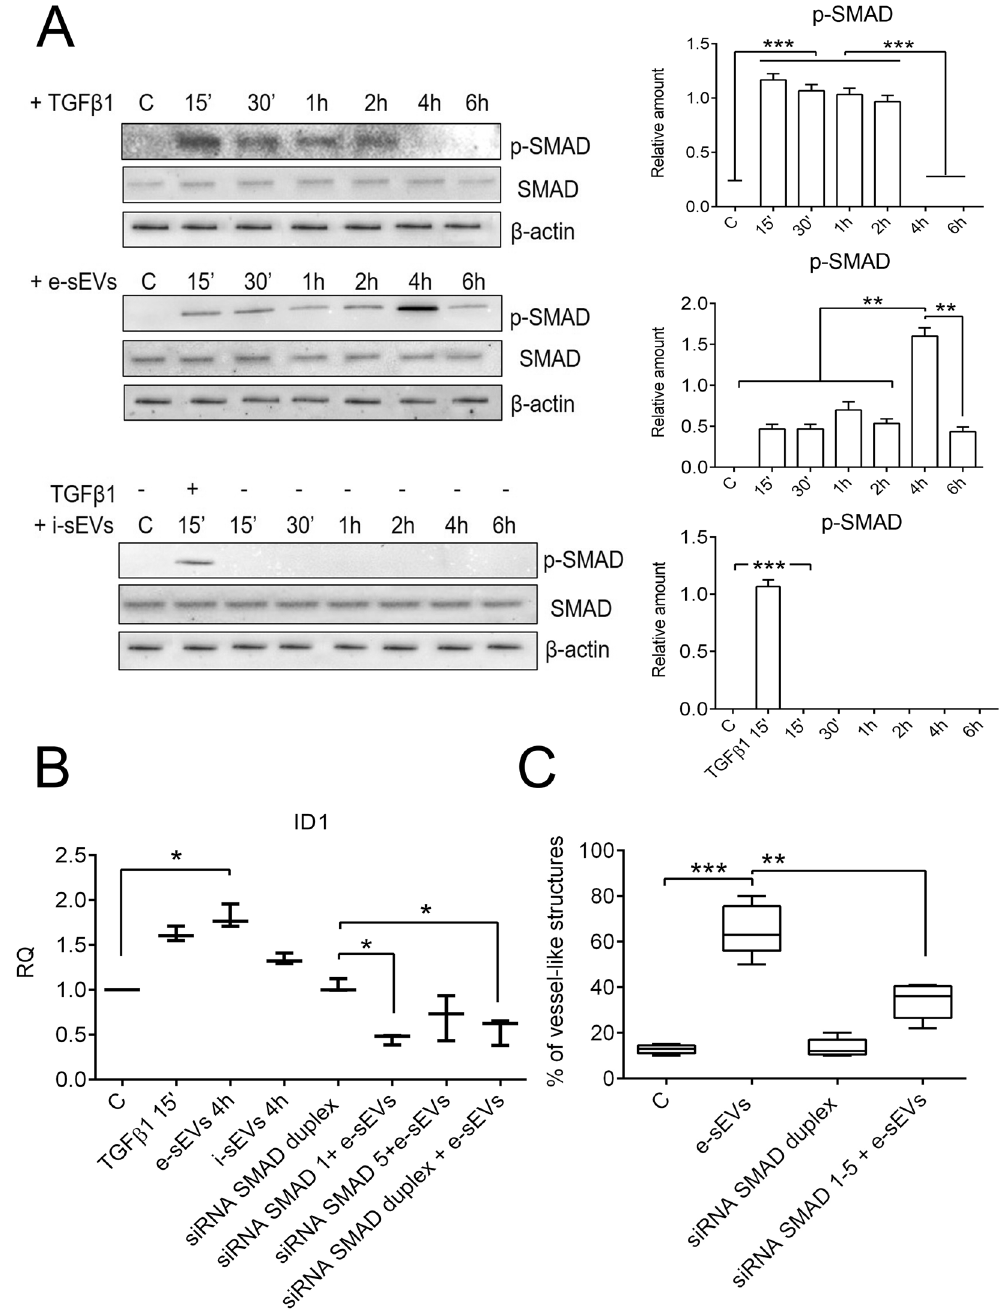
Figure 7. e-sEVs, but not i-sEVs, induce SMAD1-5 activation and lead to the formation of a SMAD1/5/ID1 transcriptional complex. ( A ) Representative SMAD1-5 phosphorylation. ECs treated for the indicated time with TGF β 1, e-sEVs and i-sEVs were lysated and analyzed by WB for p-SMAD 1/5, SMAD 1/5 and normalized to β -actin content. The results are representative of four different experiments ( n = 4) ** p < 0.01; *** p < 0.001 (One-way ANOVA followed by Tukey’s multicomparison test). ( B ) ChIP analysis of SMAD 1/5 binding to the ID1 promoter region using ECs treated for four hours with e-sEVs and i-sEVs and 15 minutes with TGF β 1. RQ values of RT-PCR are reported. Selected siRNAs for SMAD1-5 (see Supplementary Fig. S4) were transfected for 48 hours and ChIP analysis was performed as described above. ECs transfected with duplex siRNAs, alone or in combination with e-sEVs, were used as controls. (n = 4) * p < 0.05 C vs TGF β 1 and e-sEVs treatment (One- way ANOVA followed by Tukey’s multicomparison test). ( C ) In vitro quantitative analysis of the % of vessel- like structures formed (tubulogenesis assay) upon siRNA SMAD duplex transfection alone or in combination with e-sEVs. (n = 4). ** P < 0.01 e-sEVs vs siRNA SMAD1-5 + e-sEVs; *** p < 0.001, C vs e-sEVs, (One-way ANOVA followed by Tukey’s multicomparison